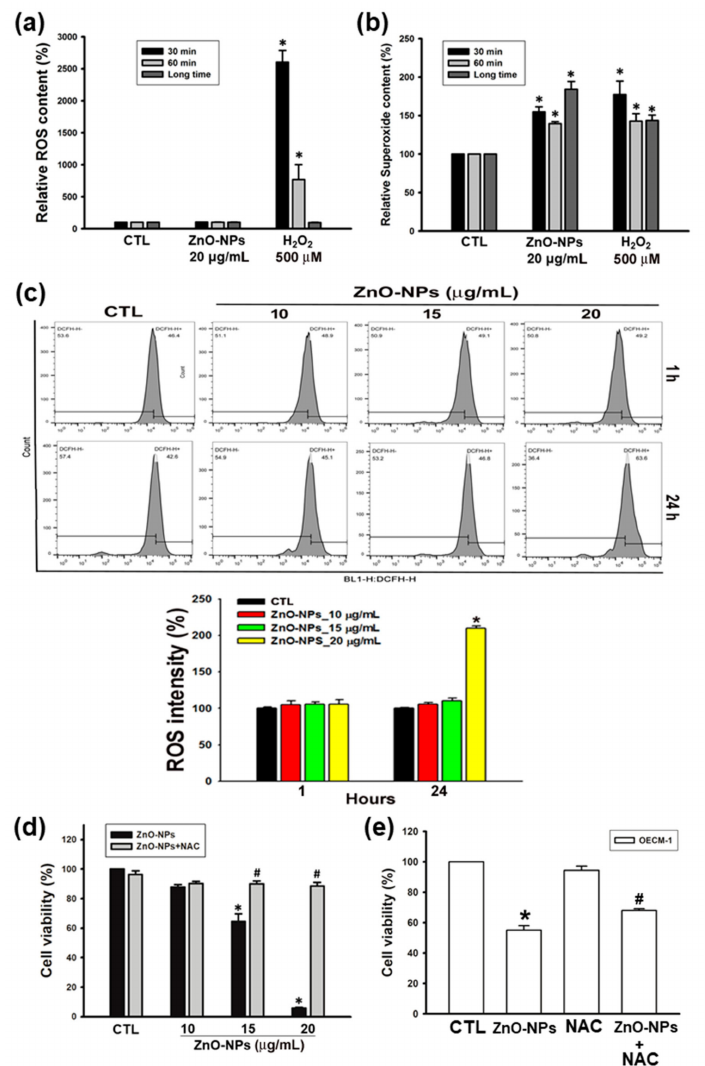
Figure 3. E ff ects of ZnO-NPs on the production of reactive oxygen species (ROS) and superoxide in human GSCC cells. ( a , b ) Ca9-22 cells were incubated with ZnO-NPs for short-term (30–60 min) and long-term (24 h) treatments. Then, the production of ROS and superoxide was examined by ROS / superoxide detection kit. H 2 O 2 was used as a positive control. ( c ) Ca9-22 cells were treated with ZnO-NPs for the indicated times to determine the intracellular ROS by flow cytometry analysis. Representative flow cytometry-based ROS patterns are shown. The quantification of ROS intensity was analyzed using CellQuest software. ( d , e ) Ca9-22 and OECM-1 cells were treated with the indicated concentrations of ZnO-NPs with or without N -acetyl-L-cysteine (NAC) (5 mM) for 24 h. Then, the cell viability was determined using MTT assay. Data are expressed as mean ± SEM of four independent experiments. * p < 0.05 compared with control group; # p < 0.05 compared with ZnO-NP-treated